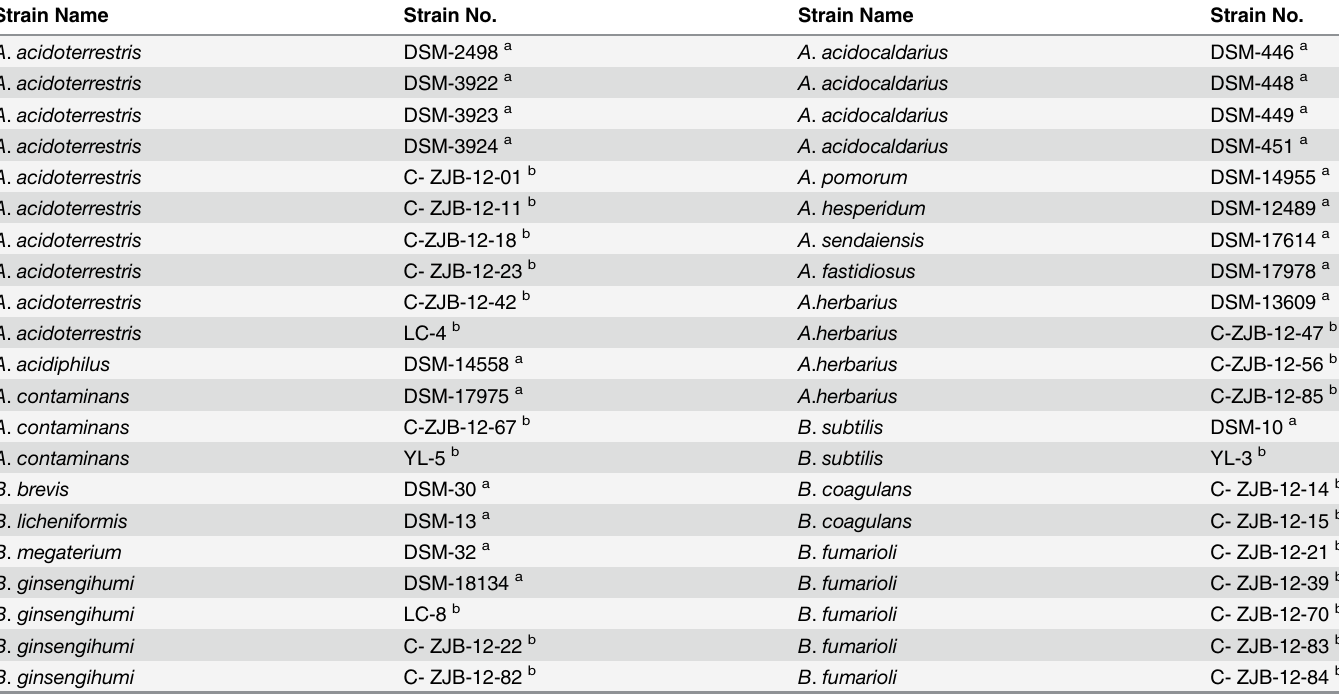
Table 1. Bacteria used for primer verification and specificity testing of the IMS- real-time PCR. Strain